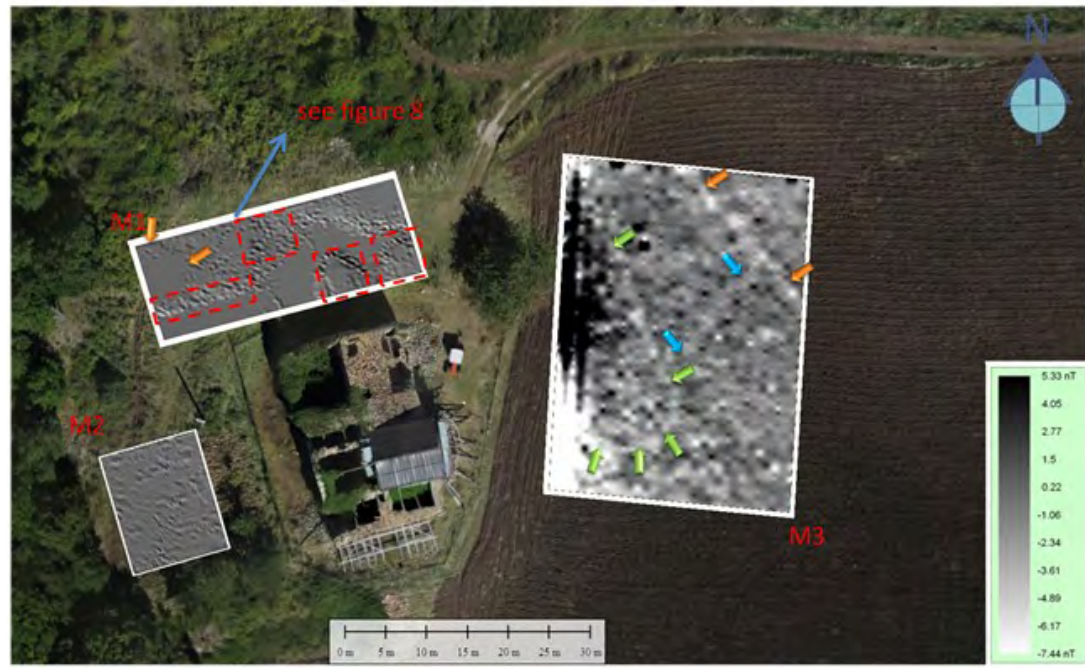
Figure 3. Gradiometric maps of the surveyed